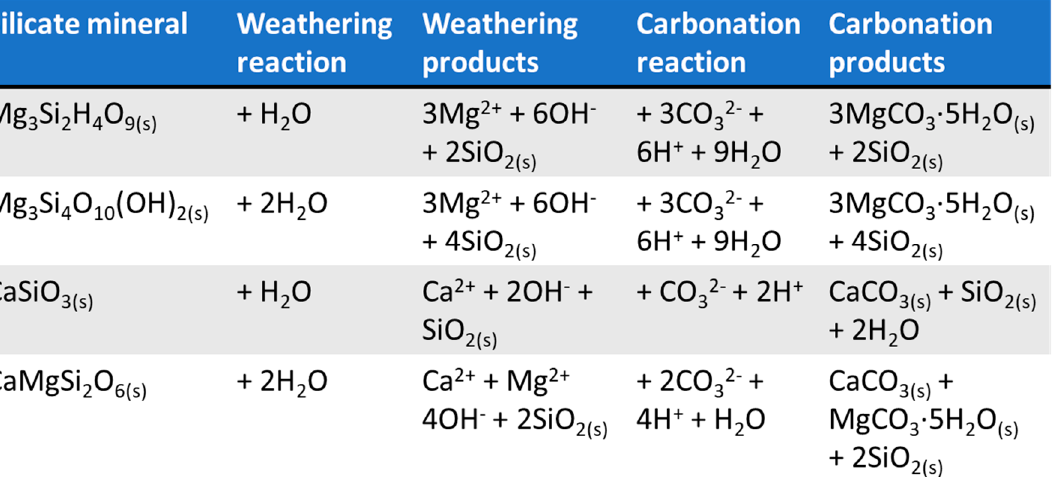
Figure 2. Schematic representation of mineral weathering and mineral carbonation reactions of the two main silicate minerals in the kimberlite and wollastonite ores used in this work; lansfordite is assumed to be the magnesium carbonate forming, but other carbonates (e.g., nesquehonite, hydromagnesite or dolomite) are also possible (which would alter the reactants shown).